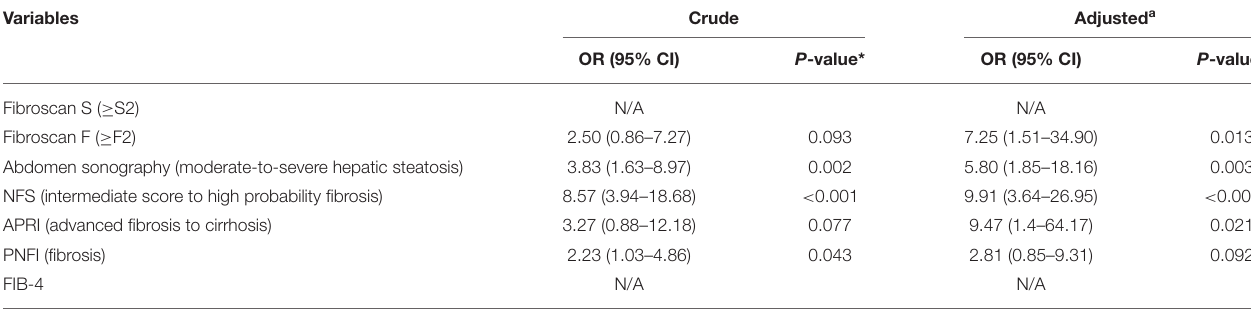
TABLE 3 | Crude and adjusted odds ratios based on a logistic regression analysis with type 2 diabetes as a dependent variable.